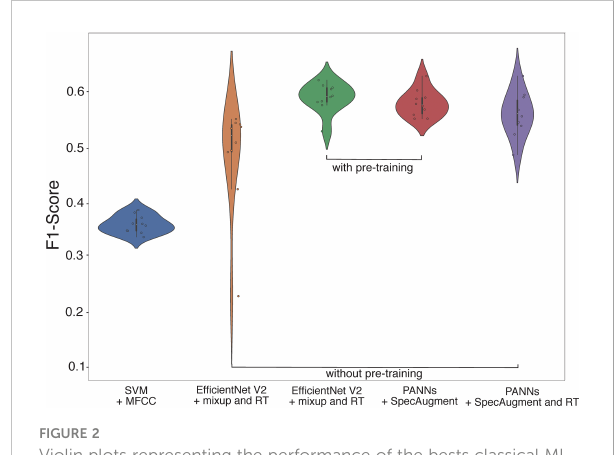
FIGURE 2 Violin plots representing the performance of the bests classical ML (SVM) and DL (Ef fi cientNet V2 Small and PANNs) models combined with different pre-processing techniques (sound feature extraction, pre-training, and/or data augmentation) at recognizing bee species based on buzzing sounds recorded during visits to fl owers of blueberry cultivars in southern Chile. Classi fi er performance was based on Macro-F1 score (MacF1); Each dot represents the F1 score achieved by an independent model run (10 runs per model, 120 epochs). Note the effect of pre-training which increased the performance of DL classi fi ers while reducing F1-score